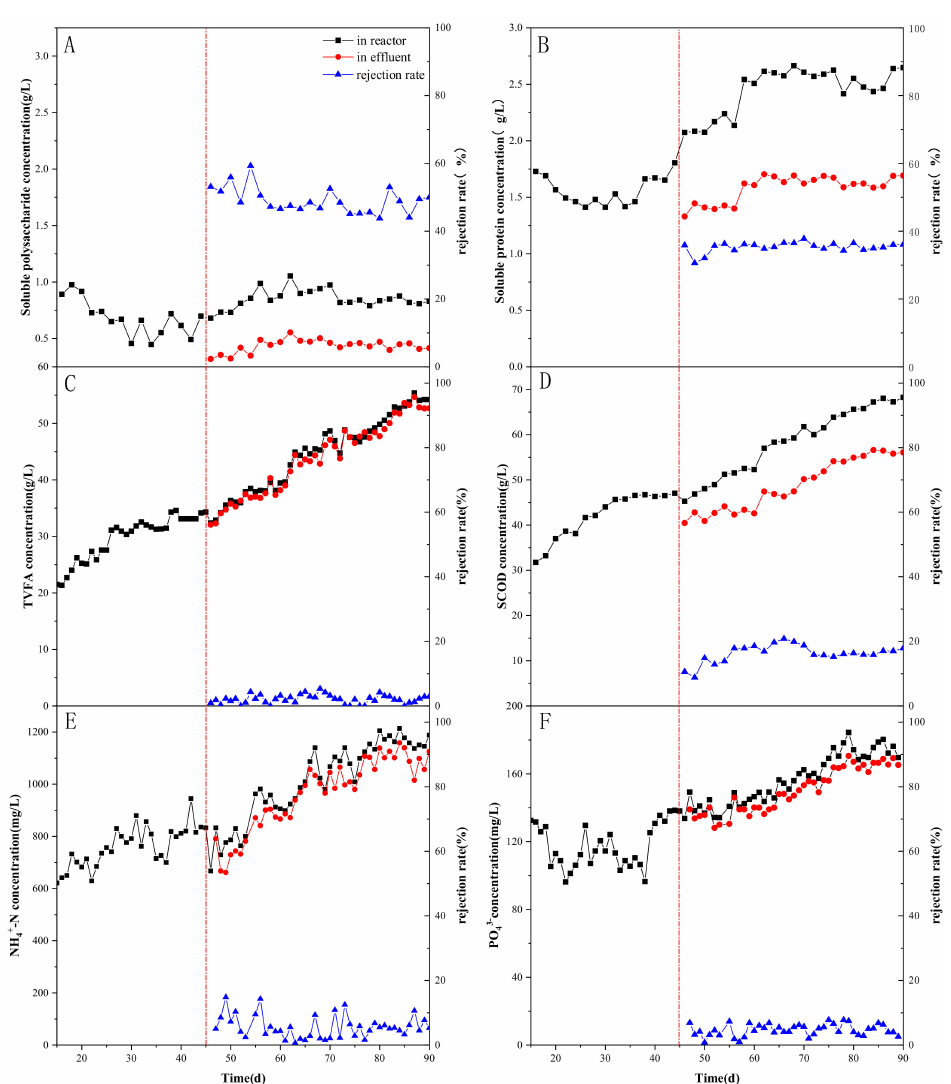
Figure 3. Variations of ( A ) soluble polysaccharide; ( B ) soluble protein; ( C ) VFAs; ( D ) soluble COD; ( E ) NH 4+ -N, and ( F ) PO 43 − in the reactor with operation